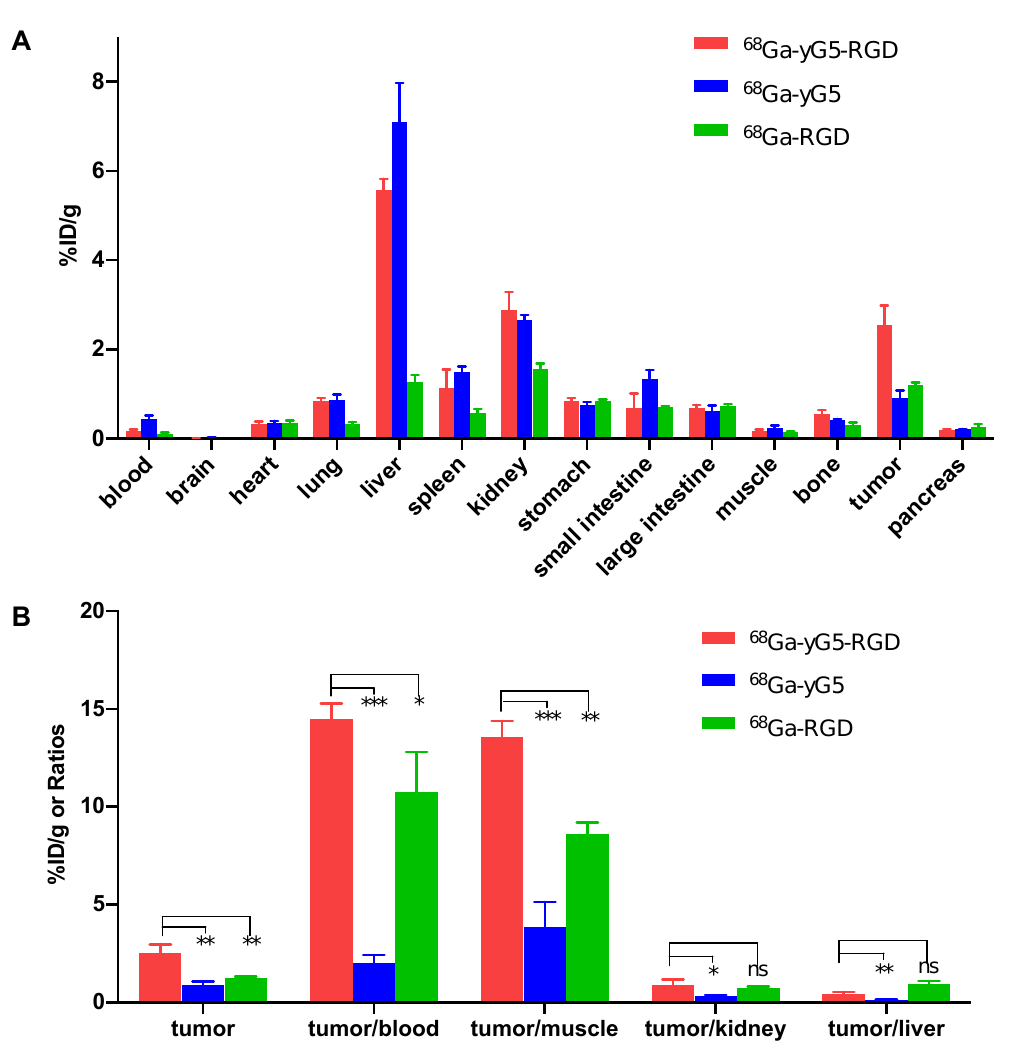
Figure 4. Biodistribution studies of the tracers. ( A ) Biodistribution studies of 68 Ga-yG5-RGD, 68 Ga- yG5, and 68 Ga-RGD in BxPC3 xenograft mice at 2 h p.i. (each 5.55–7.4 MBq). ( B ) Analysis of tumor-to-blood, tumor-to-muscle, tumor-to-kidney, and tumor-to-liver ratios. Data are expressed as mean ± SD, n = 4; ns: not significant, * p < 0.05, ** p < 0.01, *** p < 0.001. To validate the in vivo targeting specificity of 68 Ga-yG5-RGD, blocking biodistribution assays were conducted in BxPC3 xenograft mice. Each mouse was intravenously injected with 68 Ga-yG5-RGD alone or co-injected with AMD3100 (10 mg/kg), RGD (10 mg/kg), or AMD3100 (10 mg/kg) + RGD (10 mg/kg). Mice were sacrificed at 2 h p.i., and ex vivo biodistribution analyses were performed. BxPC3 tumor uptake of 68 Ga-yG5-RGD in the blocked groups (AMD3100, 0.89 ± 0.28 %ID/g, p < 0.001; RGD, 0.47 ± 0.05 %ID/g, p < 0.001; AMD3100 + RGD, 0.37 ± 0.07 %ID/g, p < 0.001) was significantly reduced compared with the non-blocked groups (2.54 ± 0.44 %ID/g) (Figure 5 and Table